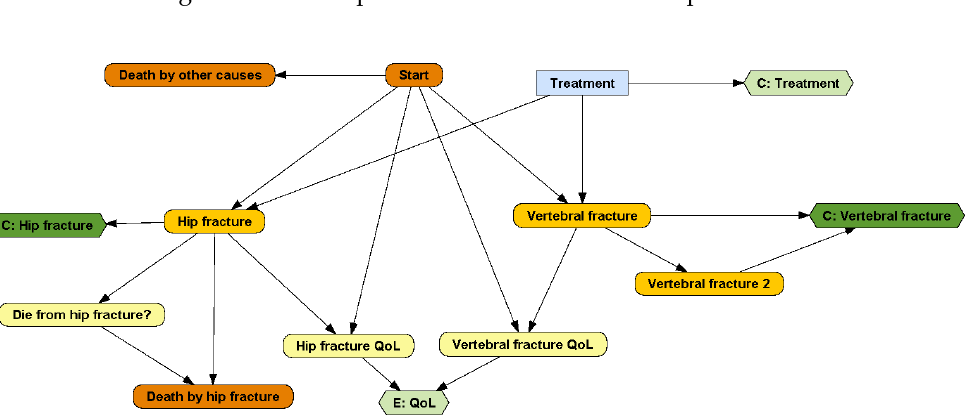
Figure 1. A DESnet for the osteoporosis model. Rectangles (in blue) represent decisions. Rounded rectangles represent probabilistic nodes, either chance variables (in yellow) or events (in orange; initial and final events are colored in dark orange). Hexagons represent payoff nodes, either one-off costs due to events (in dark green) or values that accumulate over time (in light